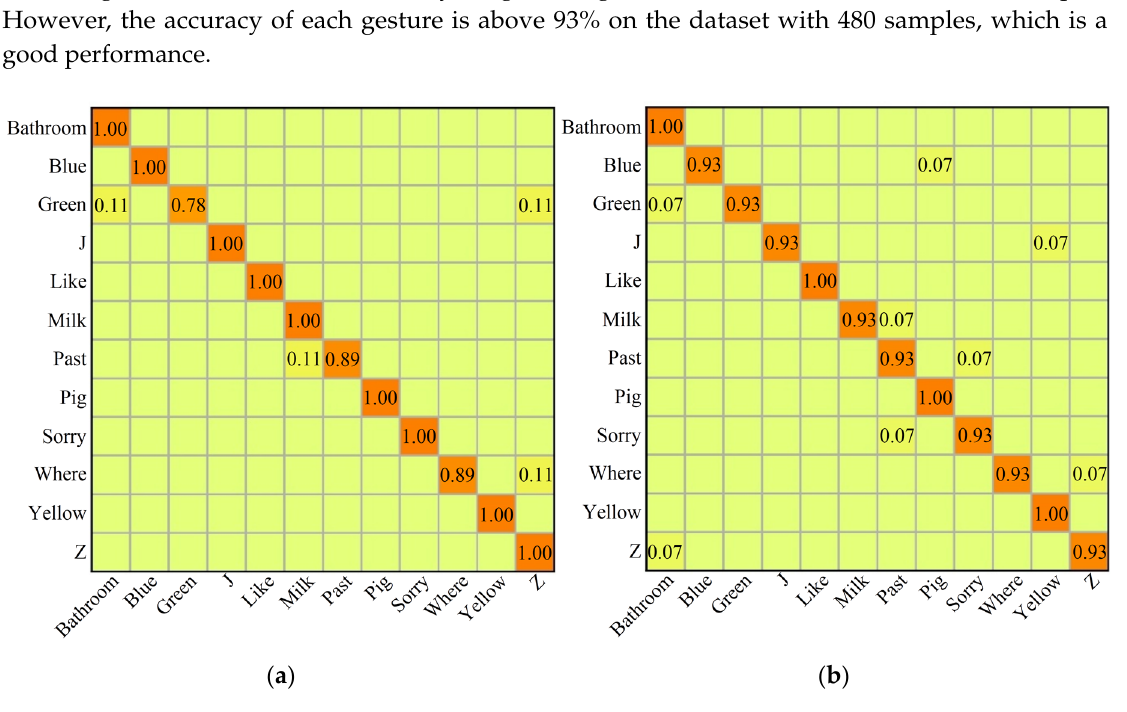
Table 2. The performance of the proposed approach on the Handicraft-Gesture